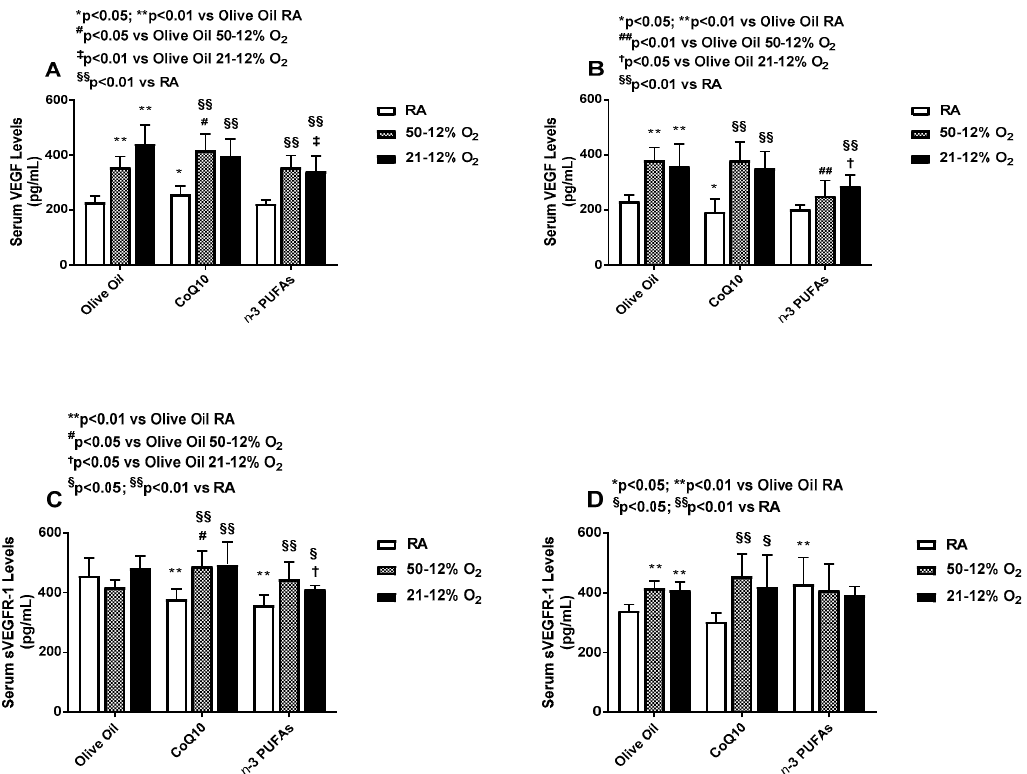
Figure 6. Effects of neonatal IH with Co-Q10 or n -3 PUFA supplementation on serum vascular endothelial growth factor panels ( A , B ) and soluble vascular endothelial growth factor receptor-1 panels ( C , D ) levels. Groups are as described in Figure 2. Data are expressed as mean ± SD ( n = 8 samples/group).